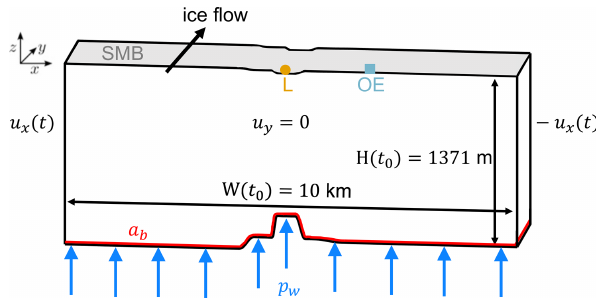
Figure 5. The cross-section of the model geometry at the end of the spin-up ( t 0 ) of the first experiment shows its corresponding width and ice thickness outside the east of the channel. The boundary con- ditions of the viscoelastic model are the water pressure p w acting perpendicular to the ice base; the displacement in the flow direction u y , which is zero due to plane strain assumptions; and the time- dependent displacement u x (t) acting in the lateral direction derived by pRES observations. The locations of the pRES station at the low- est point (L) of the channel and outside the east (OE) of the channel are shown at their position on the surface in addition to the SMB (mass increase) and the melt rate a b (mass decrease) at the base of the